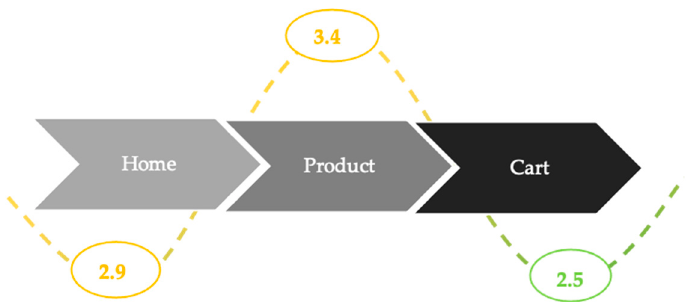
Figure 4. The customer journey for pentruanimale.ro’s users regarding loading page speed of studied touchpoints.